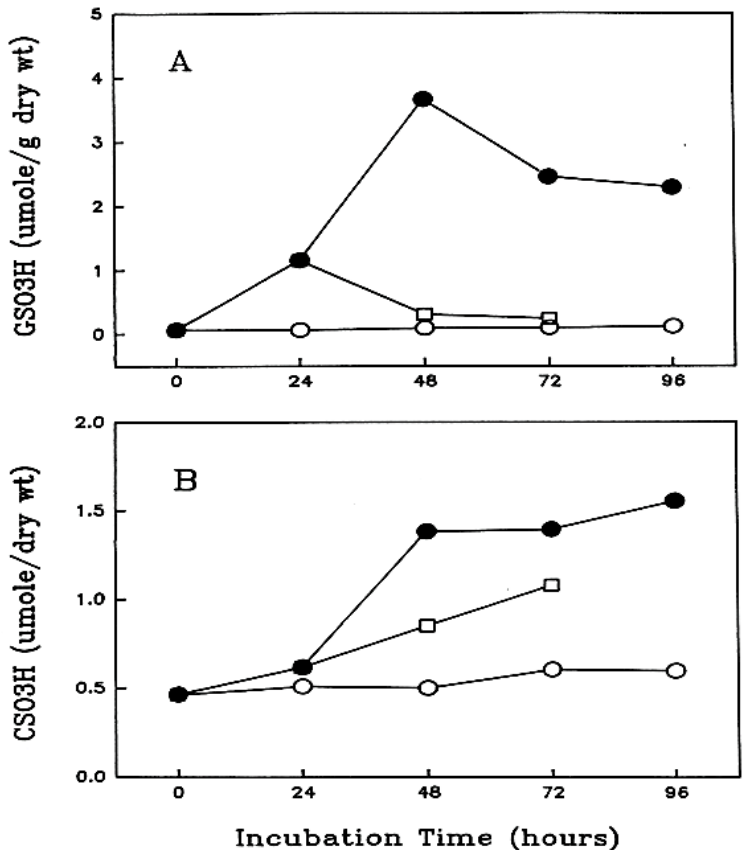
Figure 4. Formation and recovery of protein-thiol mixed disulfides in rat lenses during long term incubation with H 2 O 2 (0.5 mM). The lenses were exposed to a constant concentration of H 2 O 2 (0.5 mM). ( A ) Protein-S-S-glutathione (measured as GSO 3 H). ( B ). Protein-S-S-cysteine (measured as CSO 3 H). Five lenses of the same group were pooled and used for the analysis. Data are expressed as μmole/g dry wt., Mean ± SD, N = 5. The standard deviation values of the control and the recovery groups are too small to show in the plot. -O-: control group (untreated); - -: H 2 O 2 treated group